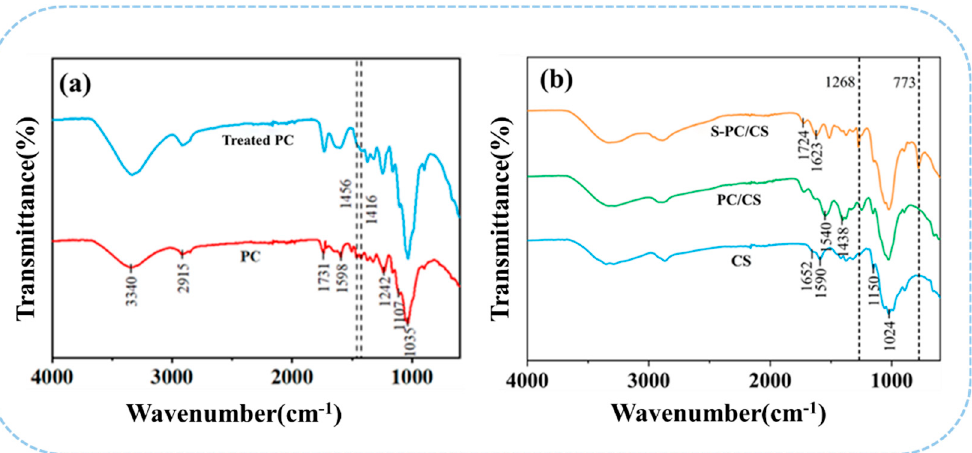
Figure 3. FTIR spectra of ( a ) treated/non-treated PC fibers as well as ( b ) CS, PC/CS, and S − PC/CS aerogel.